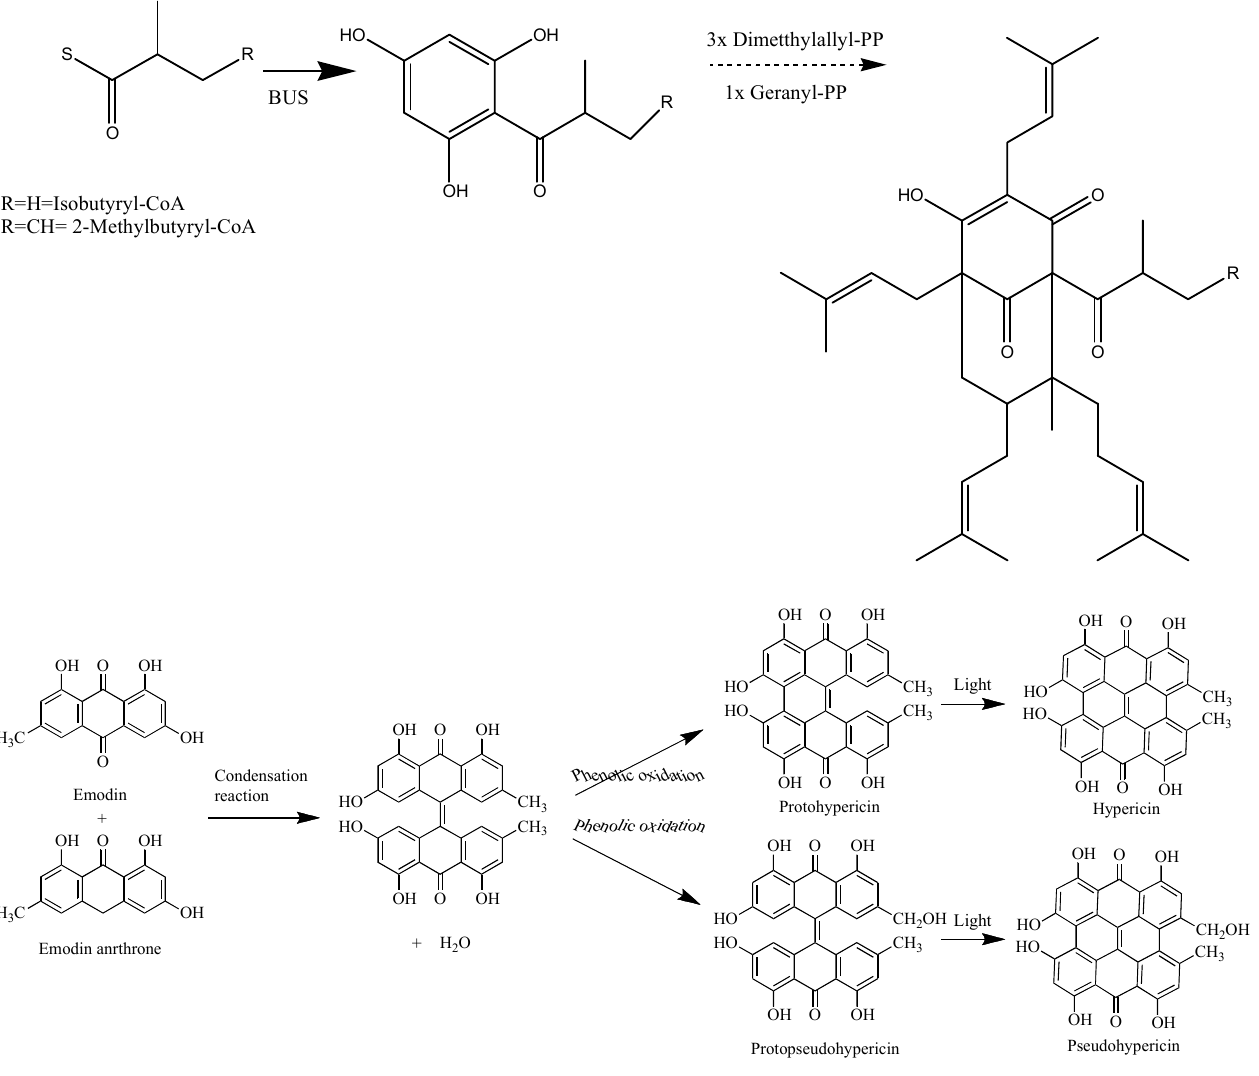
Figure 1. Basic biosynthetic pathway of hyperforins and